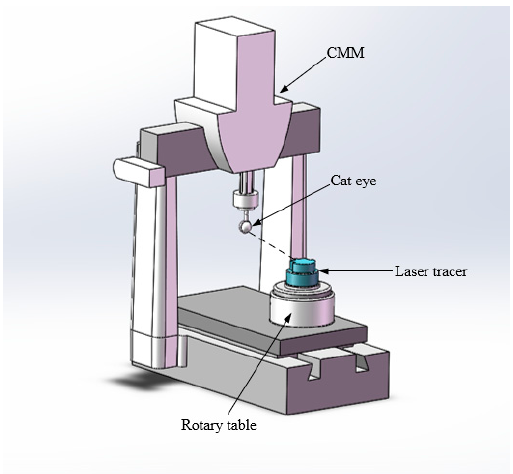
Figure 1. Laser tracer multi-station measurement model. CMM: coordinate measurement machine.